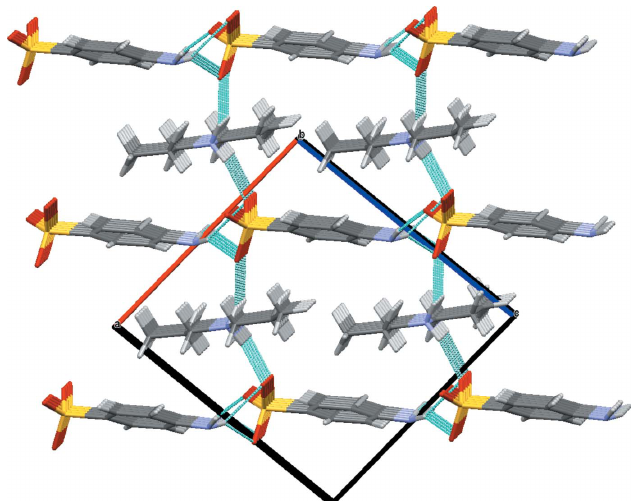
Figure 3 The packing viewed along [010].